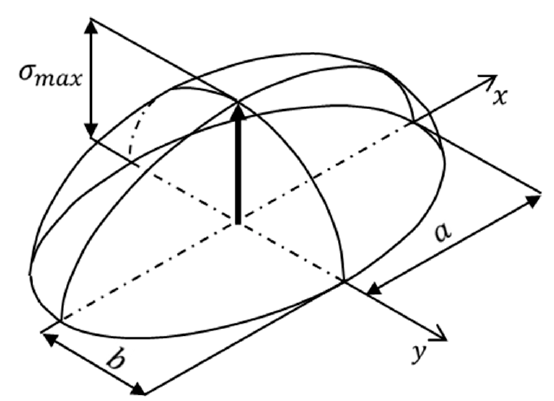
Figure 3. Stress distribution on contact ellipse.